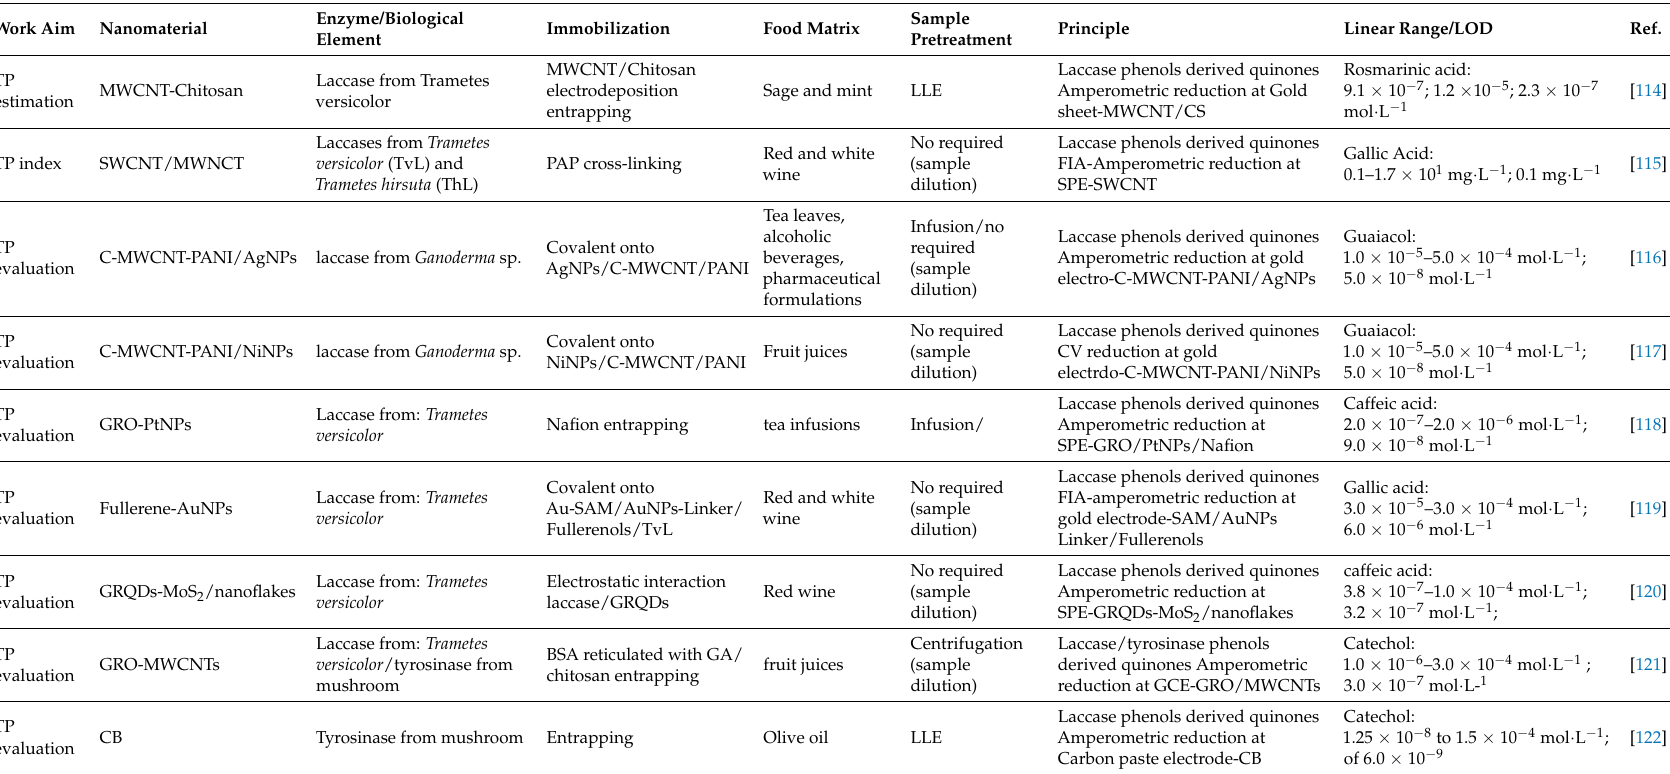
Table 3. Electrochemical enzyme sensors based on nanomaterial for food polyphenols evaluation: main features and